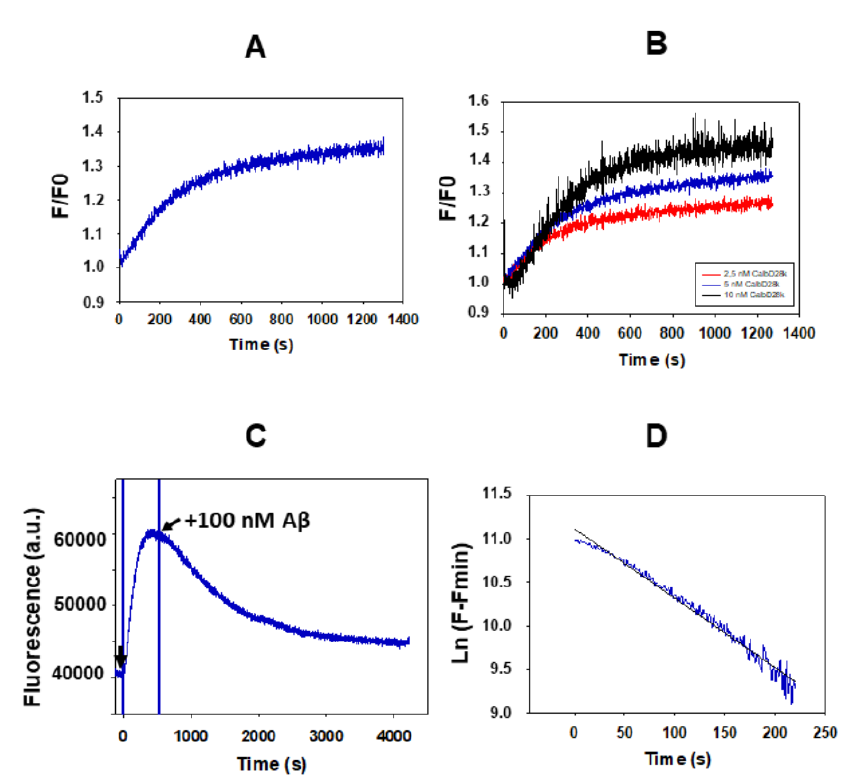
Figure 5. Kinetics of complex formation between A β (1–42) and calbindin-D28k monitored by the increase of the fluorescence of A β (1–42) HiLyte TM -Fluor555. ( A ) Representative kinetic recording of the increase of the fluorescence intensity of 10 nM A β (1–42) HiLyte TM -Fluor555 after the addition of 5 nM calbindin-D28k. ( B ) Dependence of the kinetics of increase of fluorescence intensity of 10 nM A β (1–42) HiLyte TM -Fluor555 upon the concentration of calbindin-D20k: 2.5 nM (red), 5 nM (blue) and 10 nM (black). ( C ) The increase of fluorescence of A β (1–42) HiLyte TM -Fluor555 after addition of 5 nM calbindin-D28k (first arrow) is reversed by the addition of 100 nM A β (1–42) at the point indicated by the second arrow. ( D ) The decay of the fluorescence of A β (1–42) HiLyte TM -Fluor555 after the addition of 100 nM A β (1–42) follows a first-order kinetic process with an initial lag phase of around 60 s. Fmin is the minimum fluorescence intensity at the completion of the kinetic process. The black continuous line is the linear least-squares fit of the data of the panel C to the equation: y = 11.12 − 0.007998x (R 2 = 0.982). Fluorescence measurements have been performed as indicated in the Materials and Methods, and a.u. means fluorescence units given by the fluorimeter